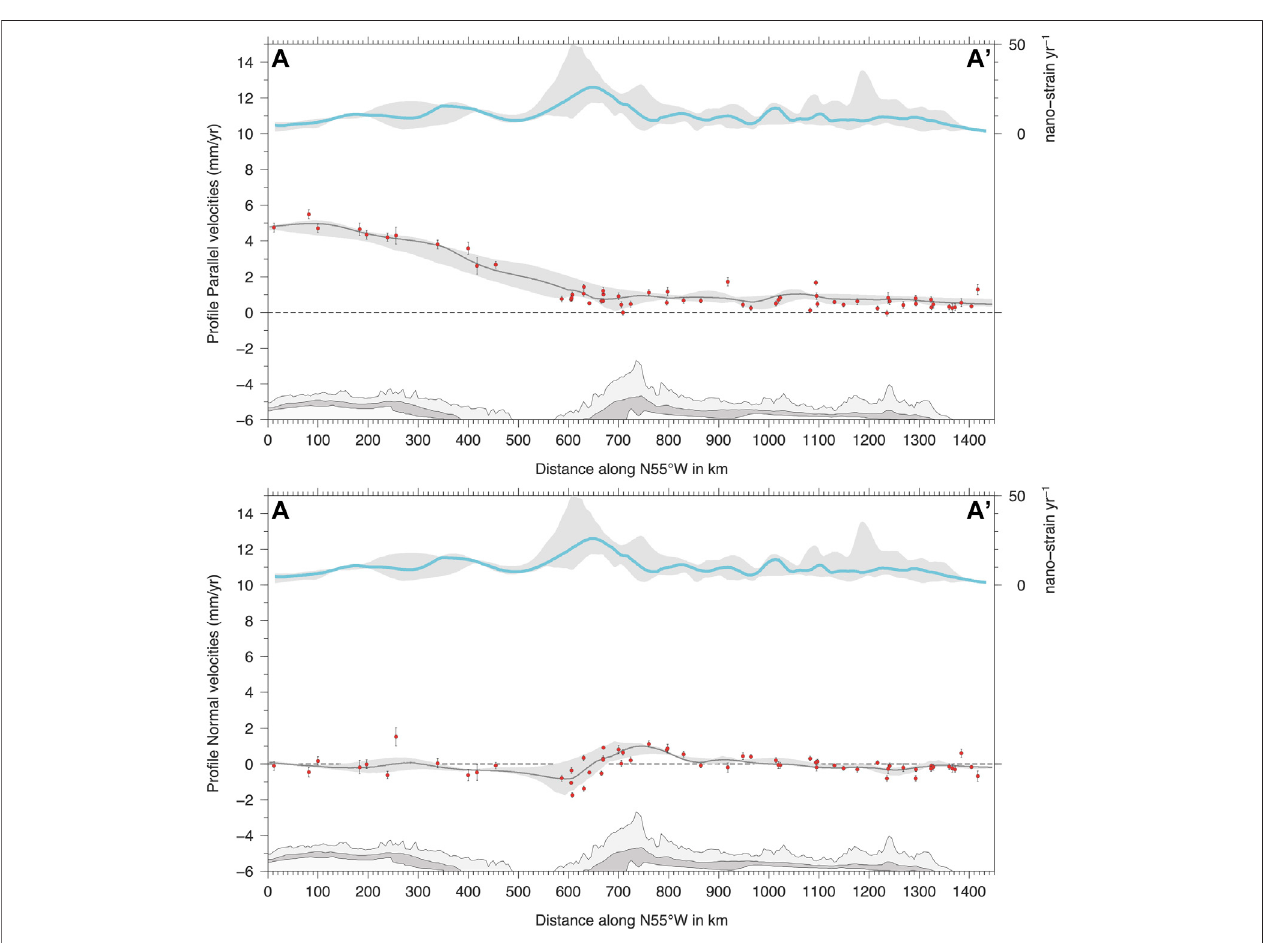
FIGURE11| Pro fi leparallel(top)andpro fi lenormal(bottom)velocitiesalongtheA-A ’ pro fi le(see Figure9 ).Theredcirclesshowtheobservedvelocitycomponents projected alongthepro fi le (with errorbars representing1 σ uncertainties) ofGNSS stations included ina200 kmwide swathpro fi le.The continuous gray linein each plot showsthe(medianvalue)modeledvelocitycomponentsfromthecontinuousvelocity fi eldobtainedusingthemultiscaleapproachdescribedin Section4.2 ( Figure8B ), wherethegrayareaistheenvelopeoftheminimumandmaximumvaluesofthemodeledvelocitycomponentsintheswathpro fi le.Thecyancontinuouslineshows the(medianvalue)scalar strain-rate (see Figure9 )where thegray areaistheenvelopeoftheminimumandmaximumvaluesofthestrain-rate valuesintheswathpro fi le. Atthe bottom ofthe fi gure, thedark gray,lightgray and whiteareas show theaverage(median), maximum and minimum elevations alongtheswath pro fi le,respectively.